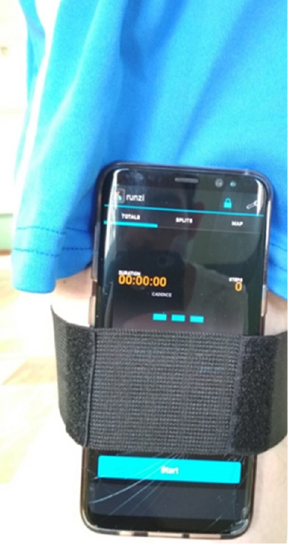
Figure 1. Smartphone mounted on the forearm of the patient. Prior to the assessment with the app, the procedure was explained to all